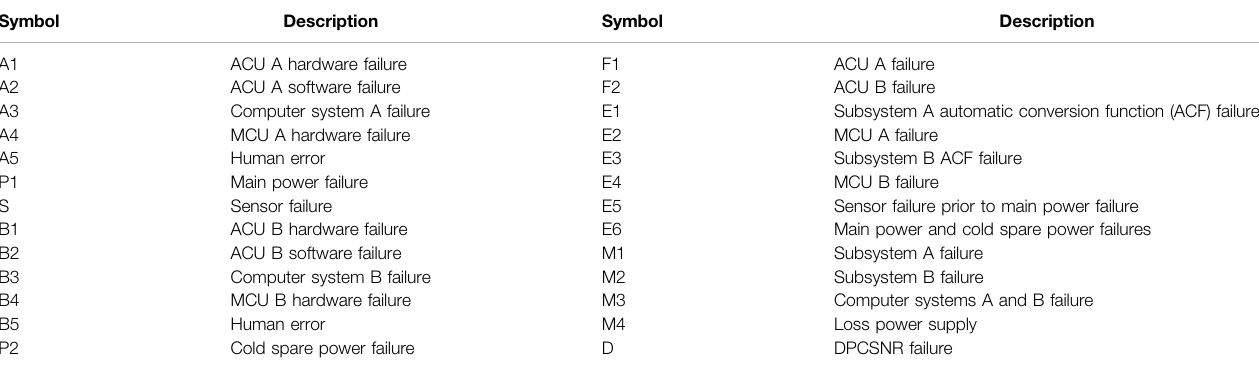
TABLE 1 | Symbols and their descriptions in Figure 3 .